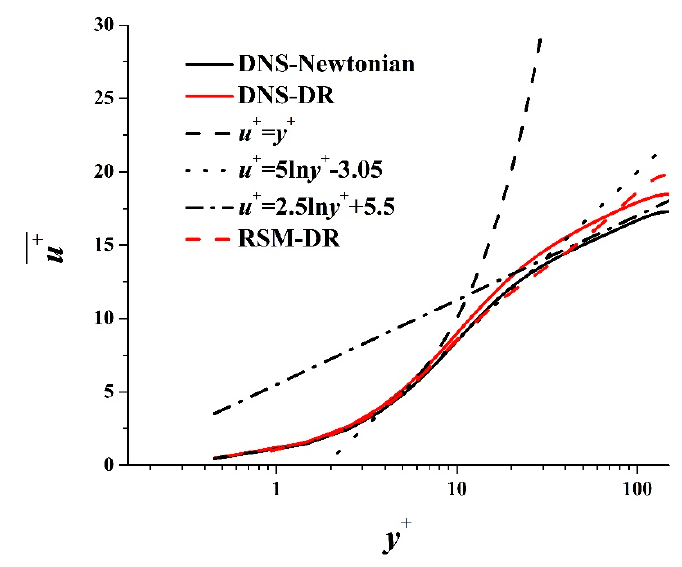
Figure 2. Time-average streamwise velocity profiles.